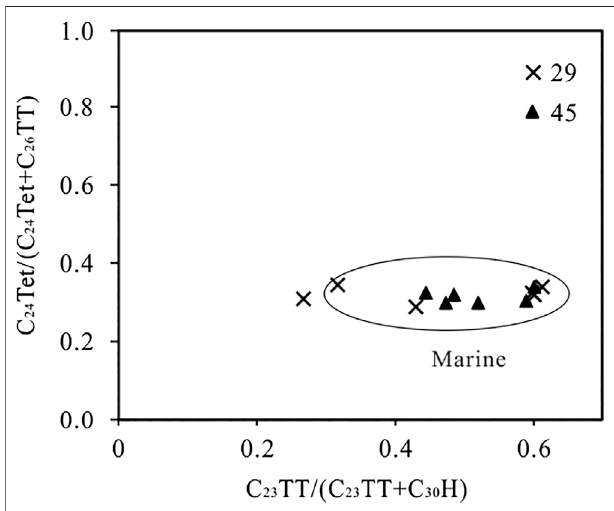
FIGURE 8 | Cross plot of C 23 TT/(C 23 TT + C 30 H) vs C 24 Tet/(C 24 Tet + C 26 TT) for core 29 and core 45 (modi fi ed after Hanson et al.,